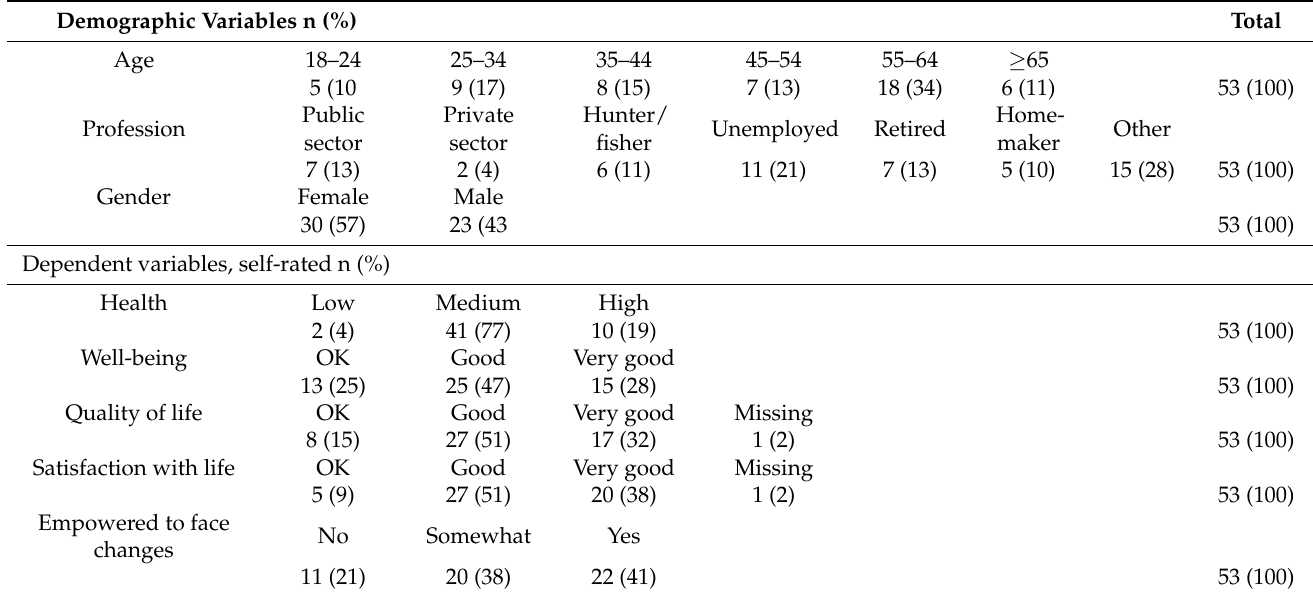
Table 1. Demographic variables and self-rated health, life balance, and feeling of empowerment to face